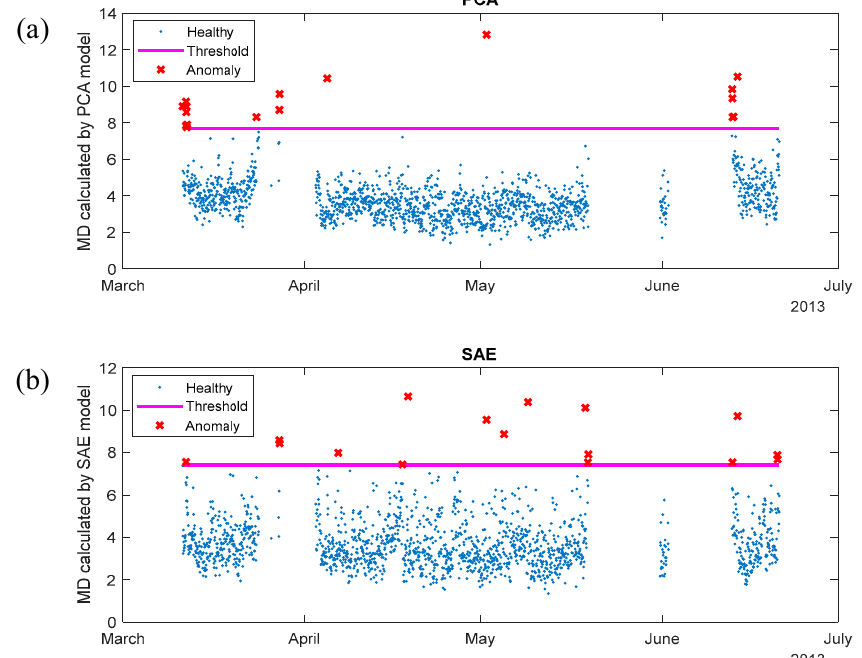
Figure 4. Mahalanobis distance (MD) fault detection thresholds calculated during the training stage from 10 March 2013 to 21 June 2013. ( a ) MD threshold calculated by principal component analysis (PCA). ( b ) MD threshold calculated by sparse autoencoder (SAE). (Blue points: healthy data; red points: anomalies; magenta line: reference MD thresholds.)